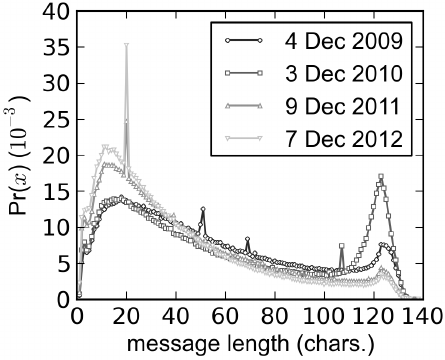
Figure 1. Utterance length distribution of the entire dataset. A. Unfiltered utterance length distribution of the entire dataset B. Utterance length distribution of English tweets with URLs and LOL removed. The solid line in both plots is the best fit of Eq. (1).